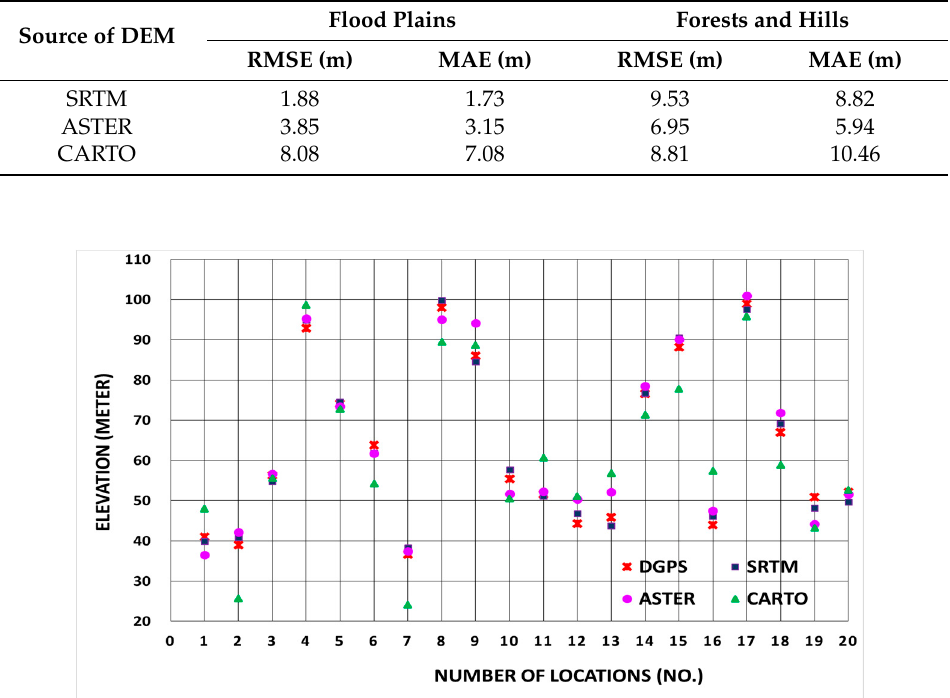
Figure 4. Comparison of elevation of the DGPS points with elevation of the SRTM, ASTER, and CARTO DEM points for flood plains.